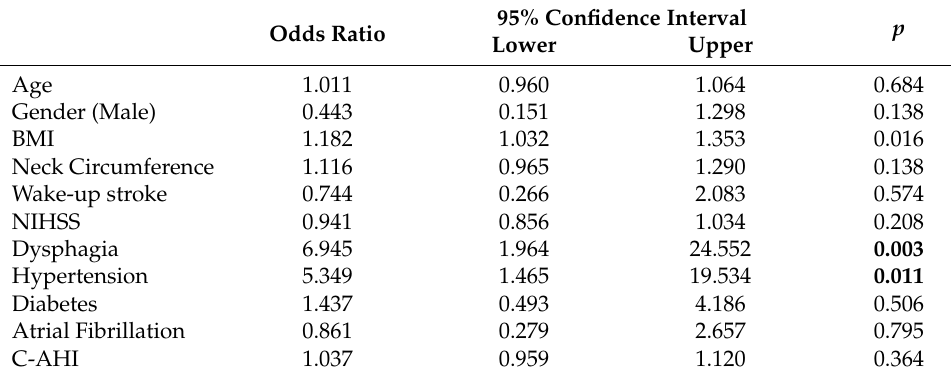
Table 3. Multivariate analysis: predictors of OSA.